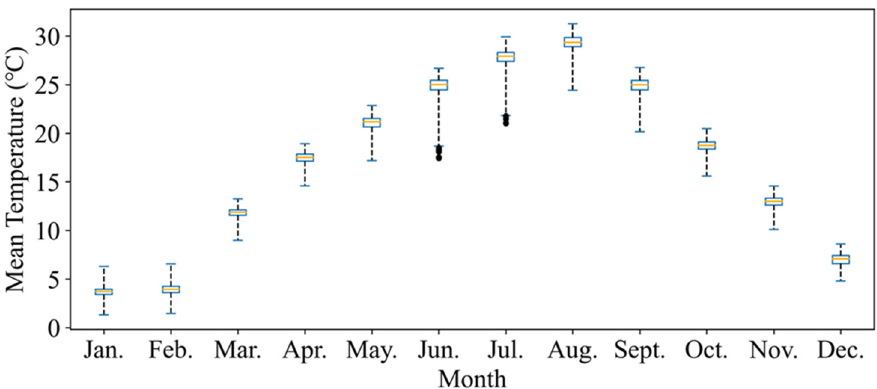
Figure 9. The spatial distributions of average fusion temperature during each season in 2019.